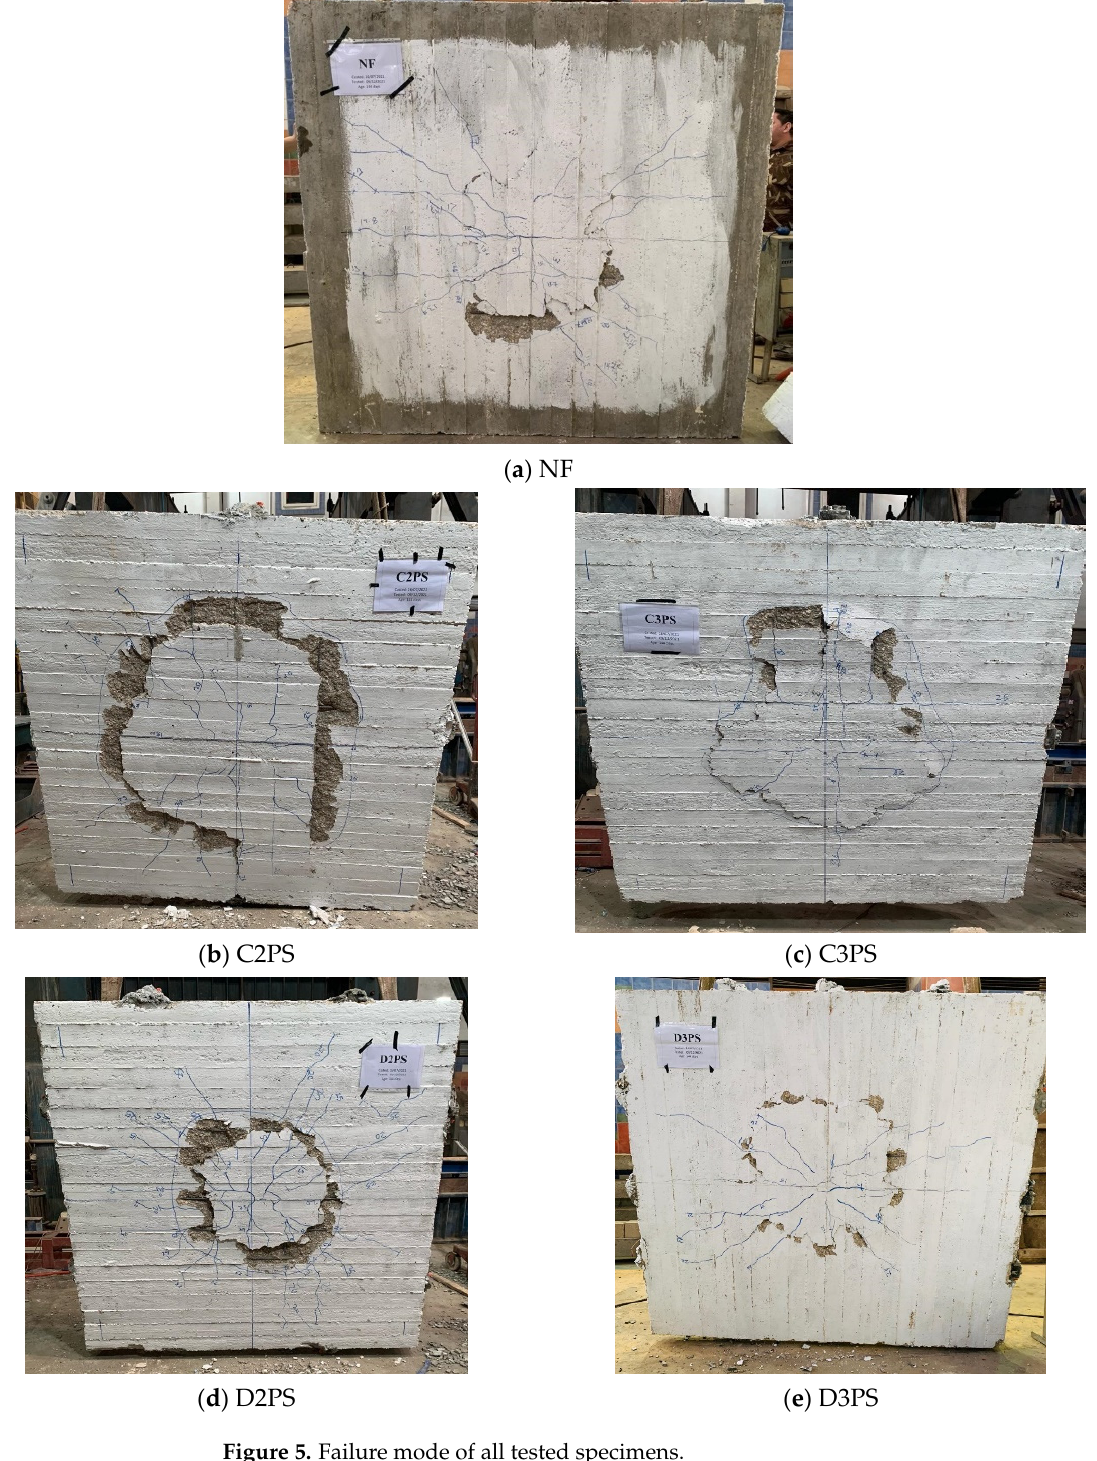
Figure 5. Failure mode of all tested specimens. Table 3. Average cone diameter and failure type for all tested specimens.